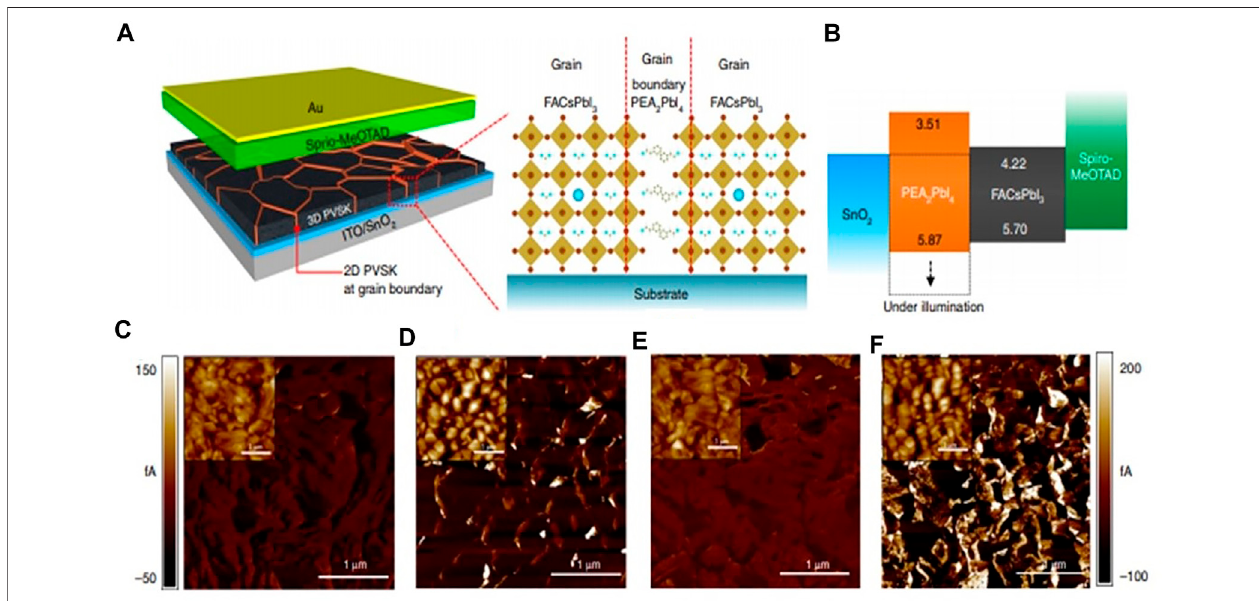
FIGURE 4 | Local conductivity and band alignment in the 2D perovskite. (A) The device schematic comprising polycrystalline fi lm of the 3D perovskite with grain boundaries containing the 2D perovskite. (B) The layer-by-layer Tauc plots and UV photoelectron spectroscopic analysis of the device band structure. The bare C-AFM images of FAPbI 3 (C, E) and with fi lms of 2D perovskite (D, F) on ITO glass coated with SnO 2 . 100 mV bias voltage was applied to get the images under the room light condition for (C, D) and low light intensity condition for (E, F), as provided by the setup. Topology of each fi lm is depicted in the inset of the corresponding images. For (C, D) and (E, F) , the scale bars are shown at the left and right sides, respectively. The fi gure is reprinted with permission from Lee et al. (2018), copyright 2018, Nature Publishing